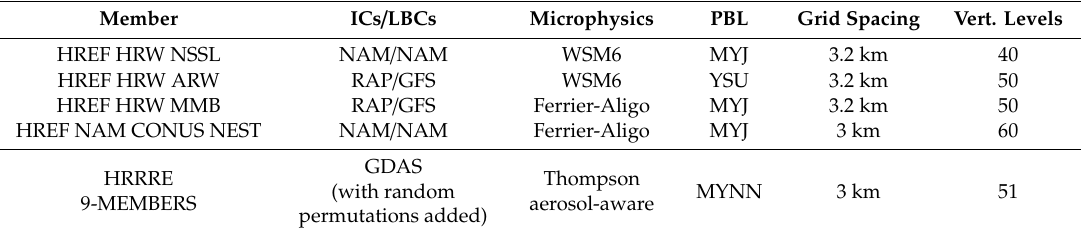
Table 2. Member configurations for the High-Resolution Ensemble Forecast version 2.0 (HREF) and High-Resolution Rapid Refresh Ensemble (HRRRE) ensembles during the study period, including initial conditions (ICs), lateral boundary conditions (LBCs), microphysics, and planetary boundary layer schemes (PBL), grid spacing, and the number of vertical